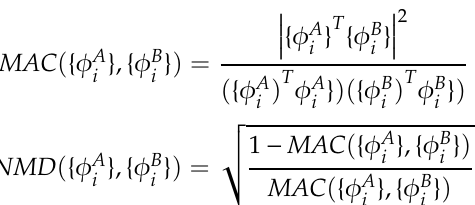
Table 6. Results of natural frequencies of Leatop